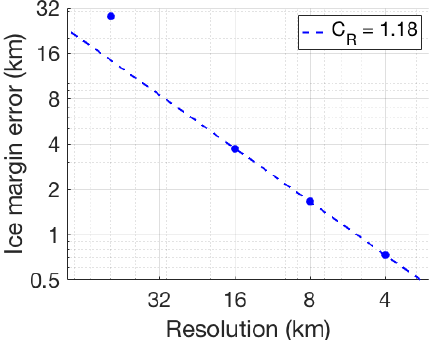
Figure A6. Modelled ice-margin error vs. ice-margin resolution for EISMINT experiment I. The dashed line is a log-linear fit of the form ae C R R , showing that the error decreases with resolution to approximately the first